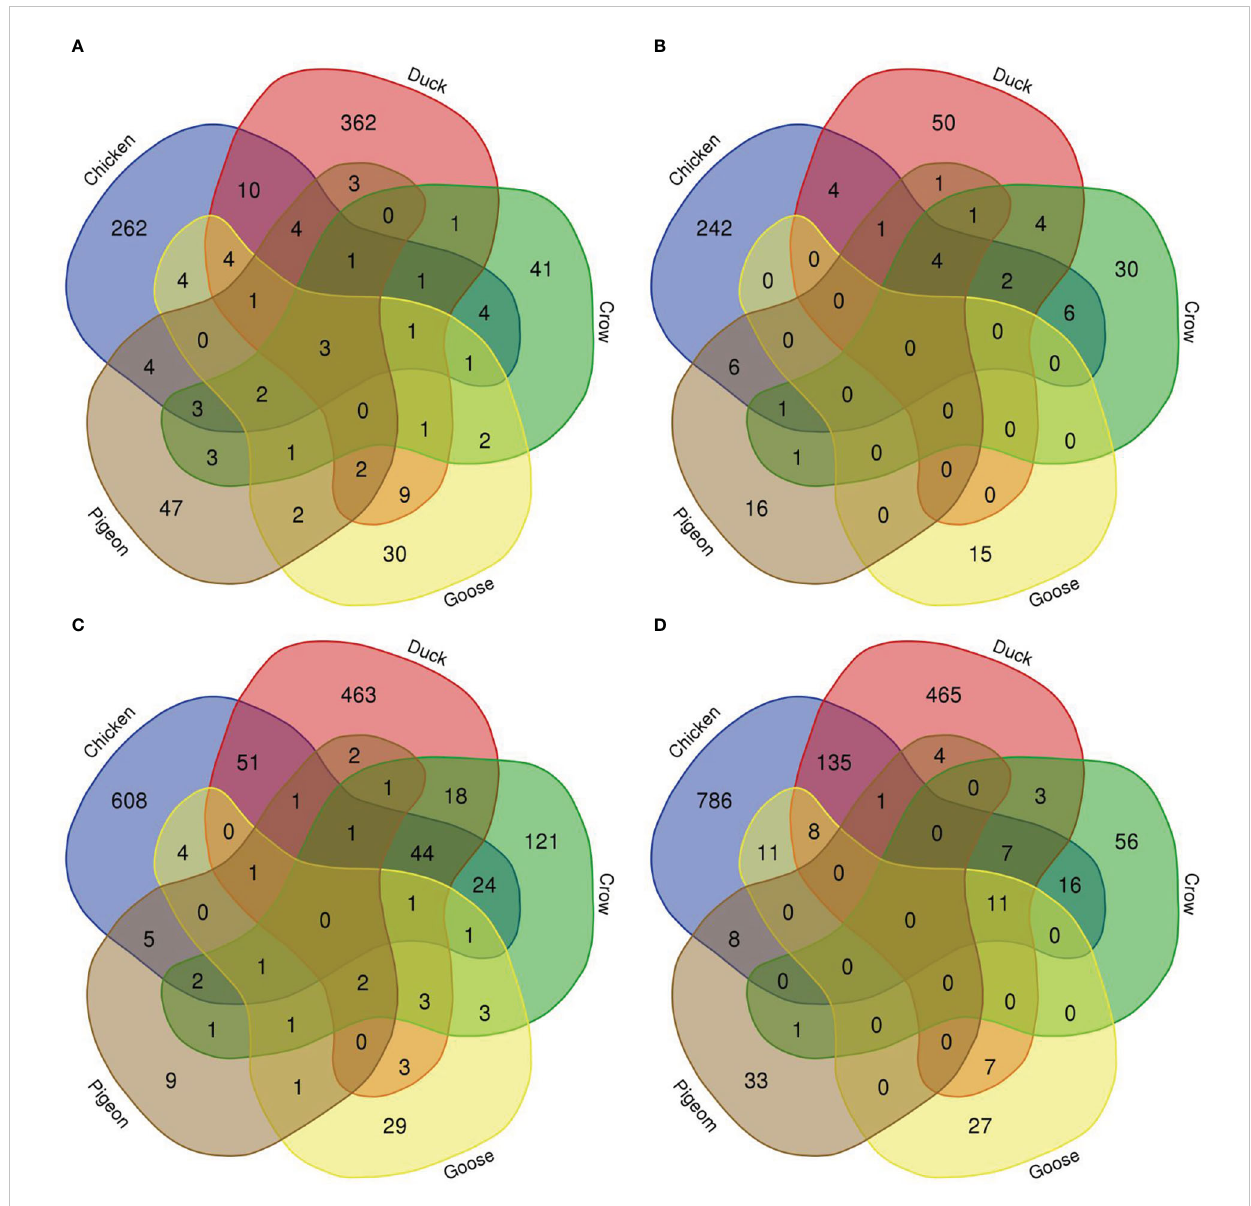
FIGURE 4 Venn diagram of genes differentially expressed in lungs in each species. (A) 12h 2.2, (B) 12h, 2.3, (C) 48h 2.2, (D) 48h